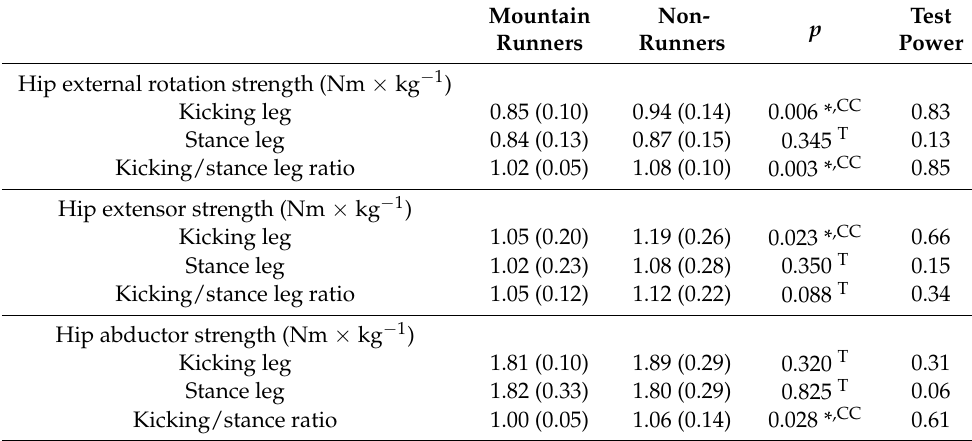
Table 4. Results (mean (SD)) of strength measurement.